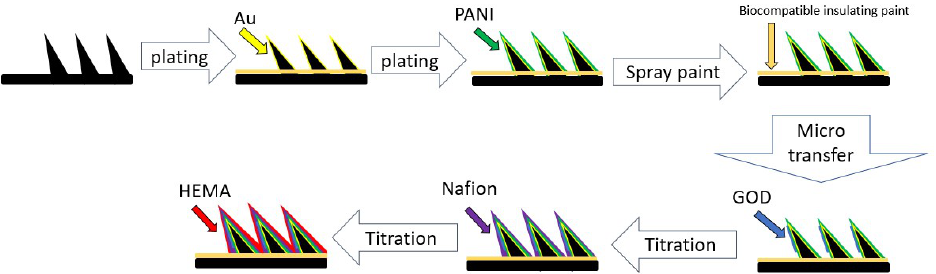
Figure 4. Schematic diagram of the coating; Au and PANI was already electroplated when the microneedle was purchased. Biocompatible insulating varnish is sprayed on before the microtransfer to isolate the signal from the area outside the glucose oxidase coating; two rounds of spraying are sufficient to achieve a good insulating effect. GOD layer: {GOD + PBS} are transferred onto electrodes using micro-transfer method and placed in a constant temperature oven for 10 min at 40 ◦ C and then removed to room temperature. Nafion layer: 10 µ L of poly HEMA is titrated onto the microneedle array using a pipette and placed in the dry (approximately 30 min). Poly HEMA layer: 10 µ L of poly HEMA is titrated onto the microneedle array using a pipette and placed in the dry (approximately 8